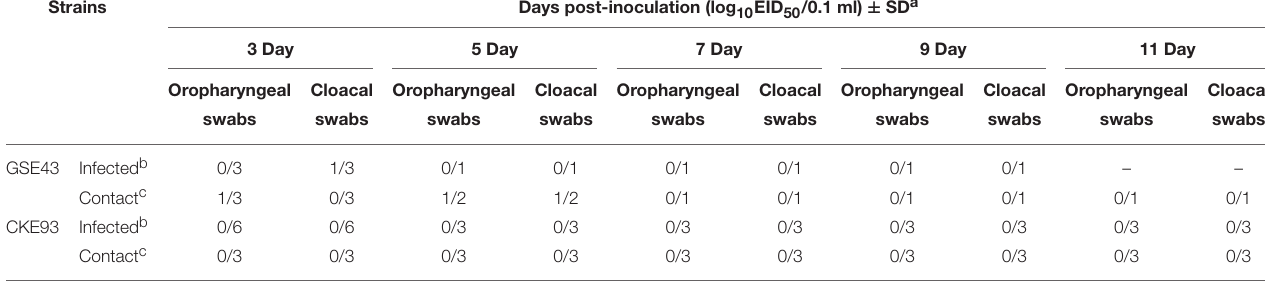
TABLE 4 | Virus titers in cloacal and oropharyngeal swabs from SPF chicken.